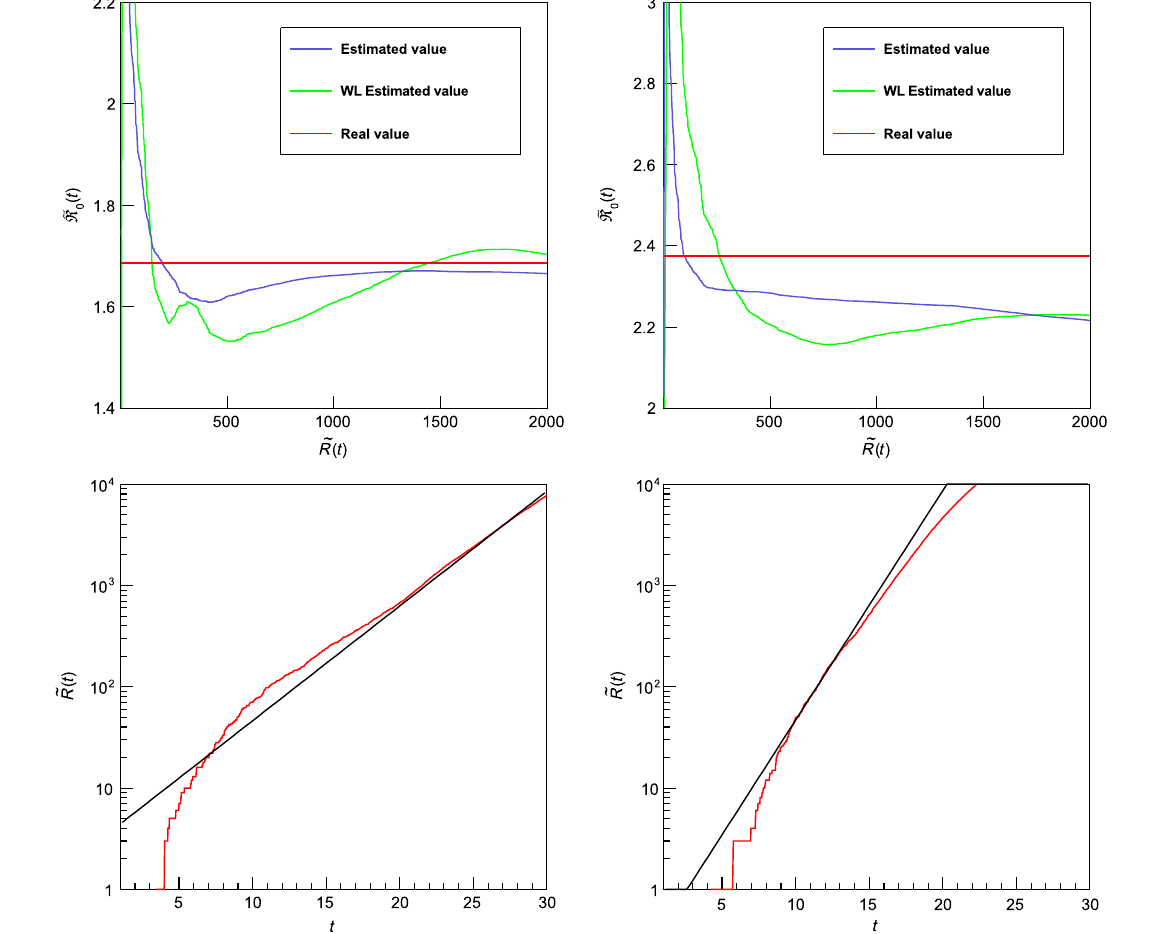
FIG. 8. Top panels: Estimated basic reproduction number for the binomial (left panel: z 1 ¼ 5 , (cid:1) i ¼ 0 : 127 71 , and (cid:1) r ¼ 0 : 25 ) and exponential (right panel: (cid:5) ¼ 4 ) networks in terms of the number of removed individuals. The red line corresponds to the real value of the basic reproduction number. The blue line shows the estimated R 0 from our methodology. For comparison, the green line shows the R 0 estimates obtained from Eq. (18) and the estimation of the growth rate during the exponential phase ( number of removed individuals by time t (logarithmic scale, base 10). The red line shows the number of removed individuals from a realization of the epidemic process. For comparison, the black line shows the theoretical exponential phase of the epidemic